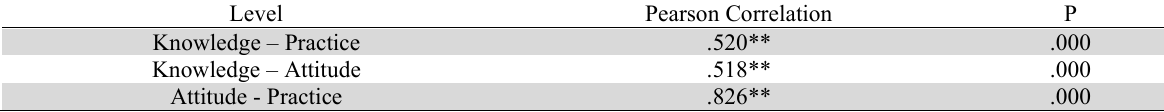
Correlation of food safety knowledge, attitude and practice level